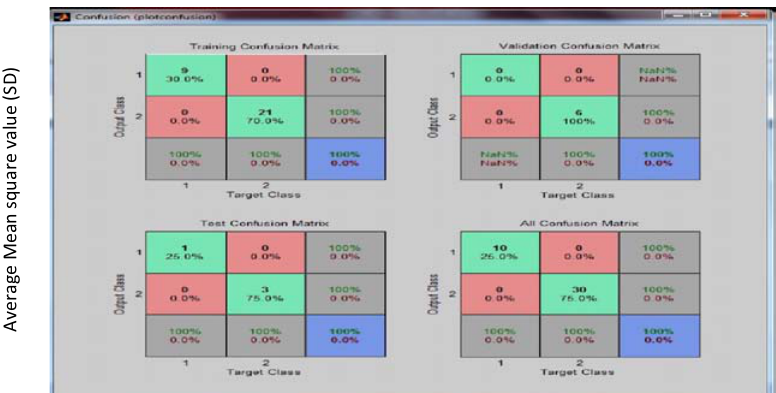
Fig. 7. Neural network based confusion